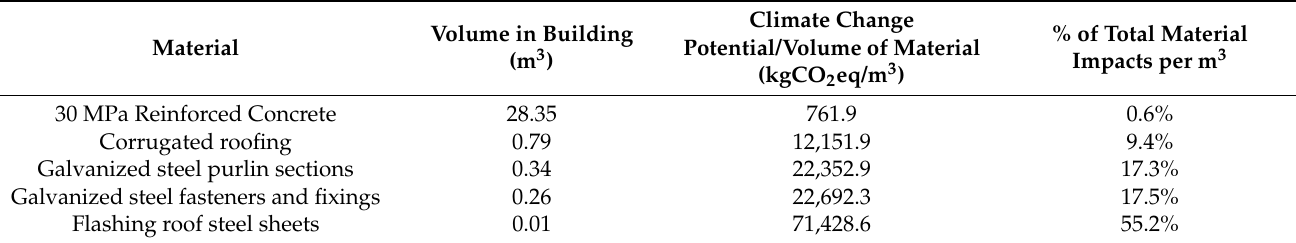
Table 3. Climate change potential of each material present per m 3 of material.